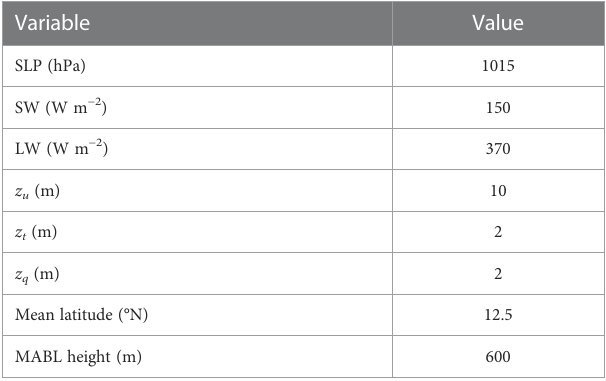
TABLE 1 COARE3.5 input parameters for SeaFlux and ERA5: Sea-level pressure (SLP), downward shortwave radiation (SW),